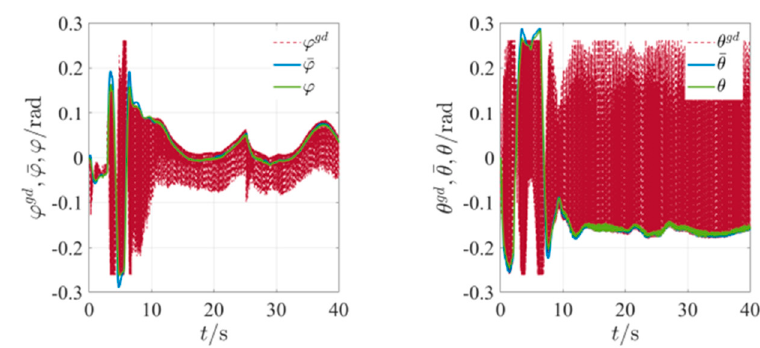
Figure 29. Diagram of the attitude angle of circular tracking.